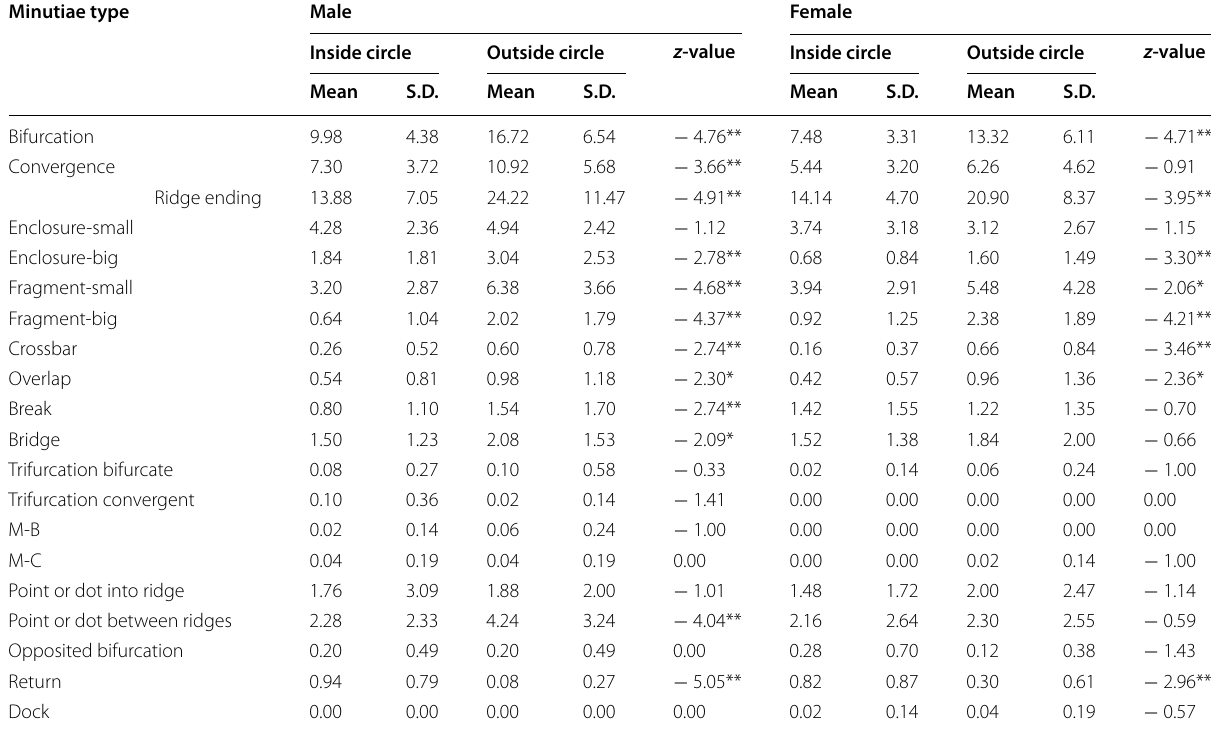
Level of significance p < 0.01**, p <